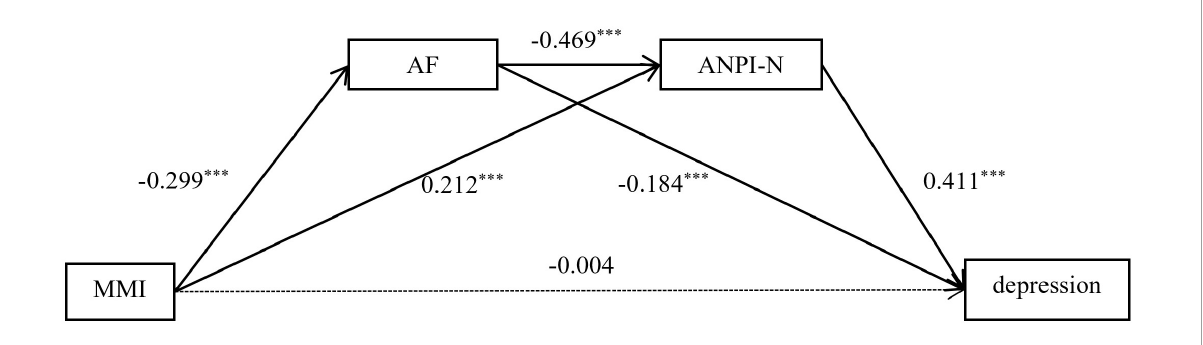
FIGURE3 The mediating pathway of attention focusing and negative information attention bias in media multitasking influence depression. MMI, Media Multitasking Inventory; AF, Attention Focusing dimension of Attentional Control Scale; APNI-N, Negative dimension of the Attention to Positive and Negative Information Scale. ∗∗∗ p <